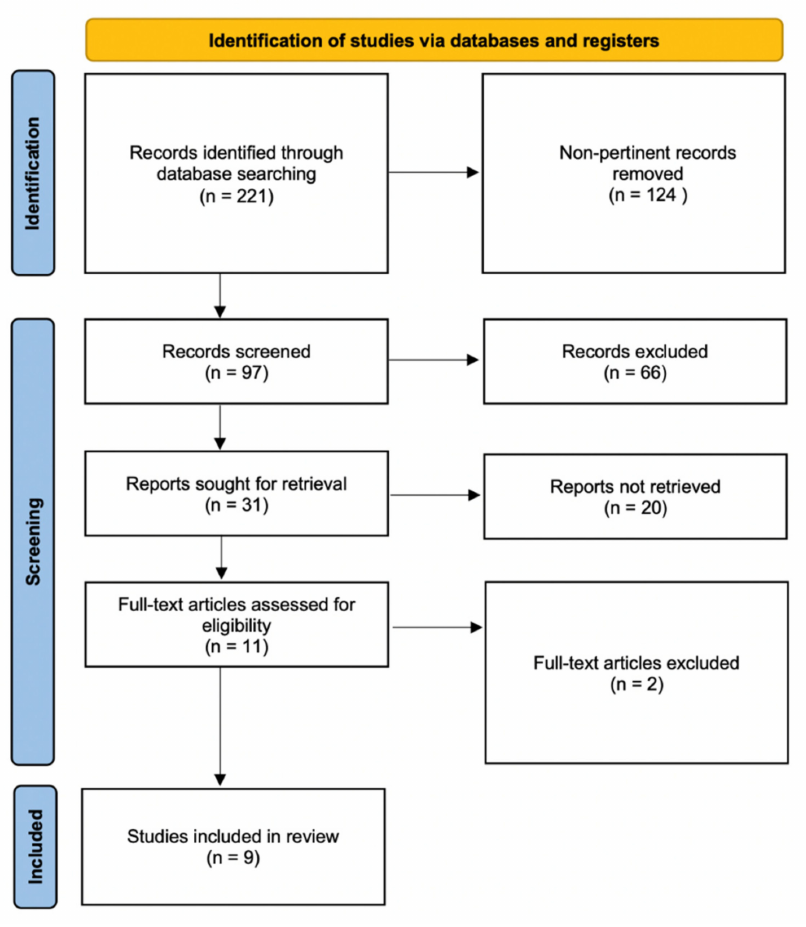
Figure 1. Literature search flowchart.